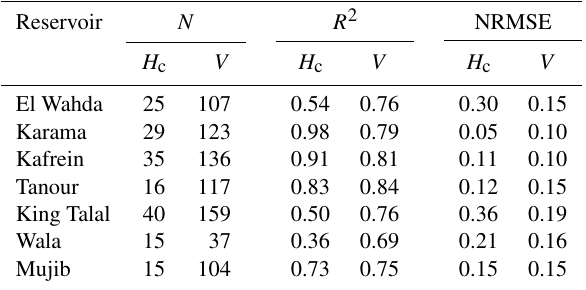
Table 2. Errors in terms of R 2 and NRMSE for Jordanian reser- voirs’ H c and V